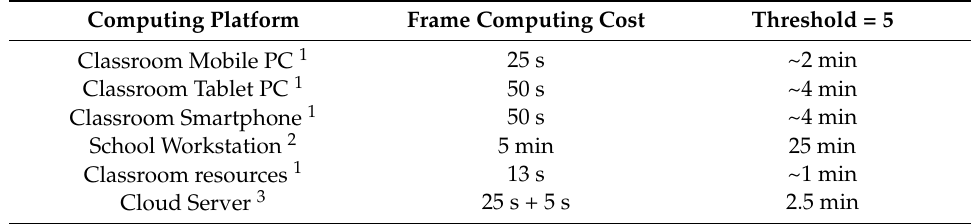
Table 2. Time estimation of fatigue analysis application.